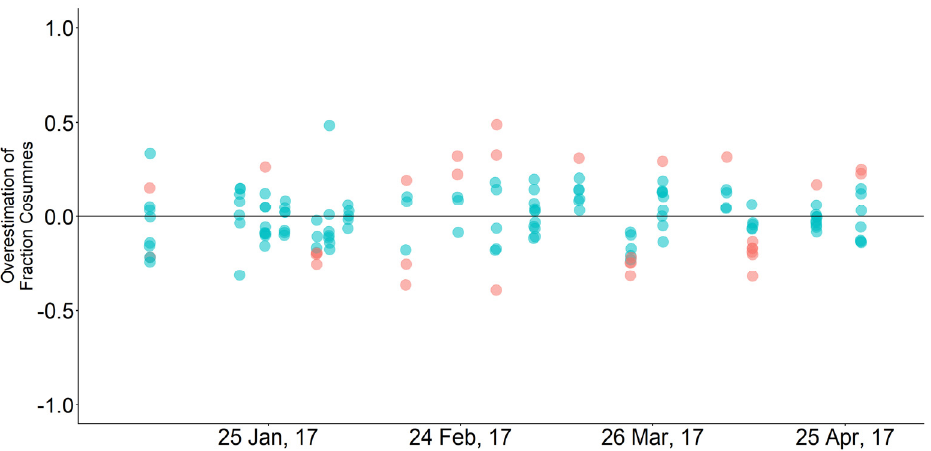
Figure 9. Time series of all locations with overestimation of the fraction Cosumnes found in the isotope method versus the hydrodynamic model method. The blue dots represent sample points whose uncertainty overlapped with the tidal envelope of the model results, and the red dots did not overlap (as in Figure 8).